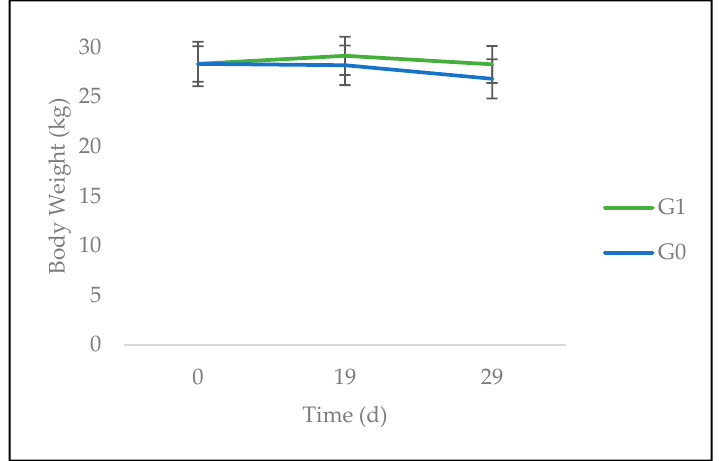
Figure 3. Evolution of body weight of sheep fed on C. nlemfuensis hay alone (G0) or G. ulmifolia foliage and C. nlemfuensis hay (G1). d: day.